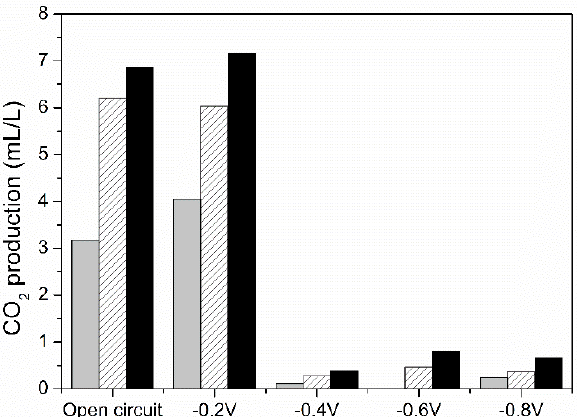
Figure 2. Photoheterotrophic-mediated electrochemical CO 2 fixation: CO 2 concentration at one (grey column), two (striped column) and three (black column) days of every experiment at different voltage.